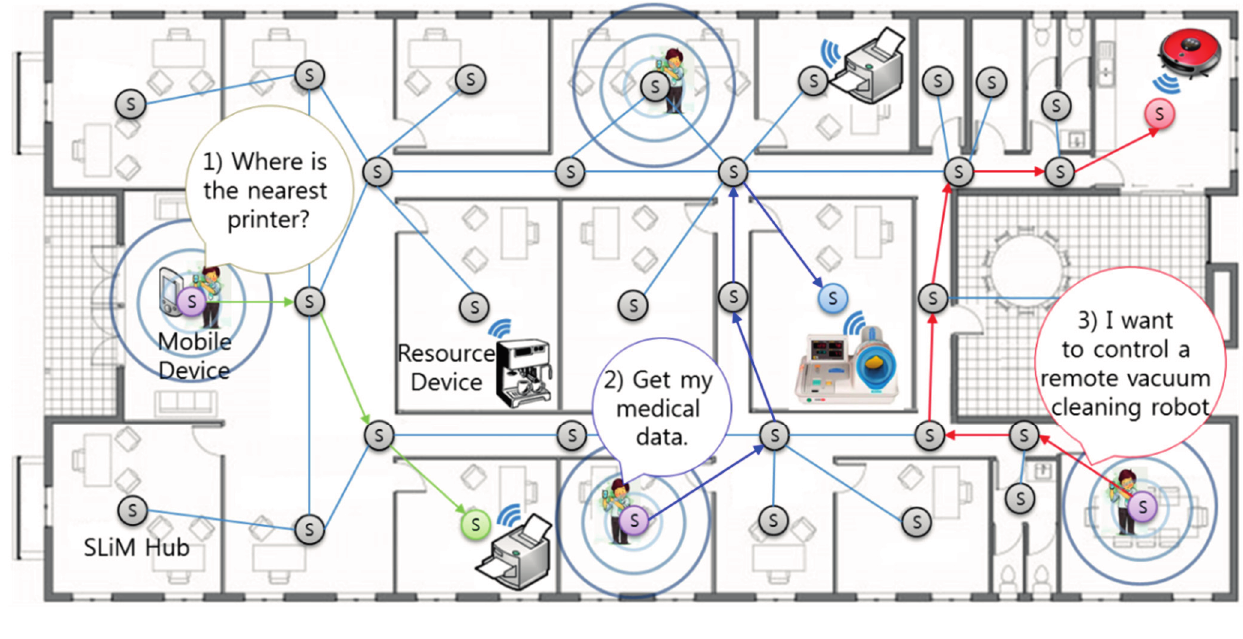
Figure 1. An example of an indoor location-based system for an office